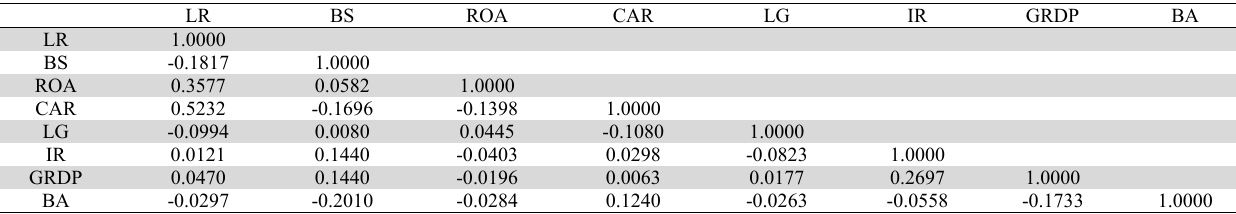
The correlation matrix of conventional